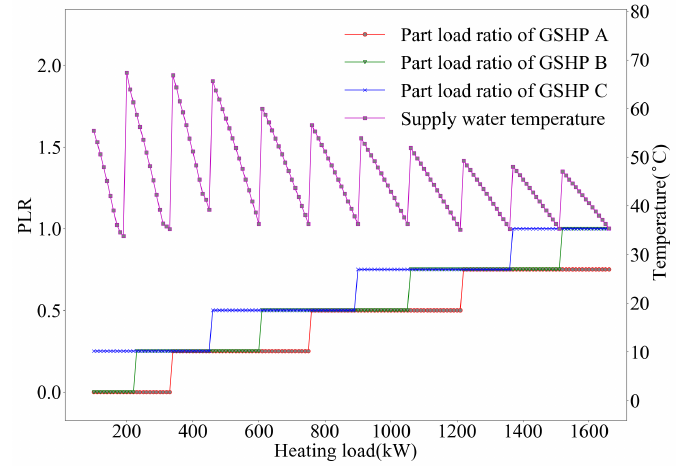
Figure 10. Optimal PLR distribution for various heat